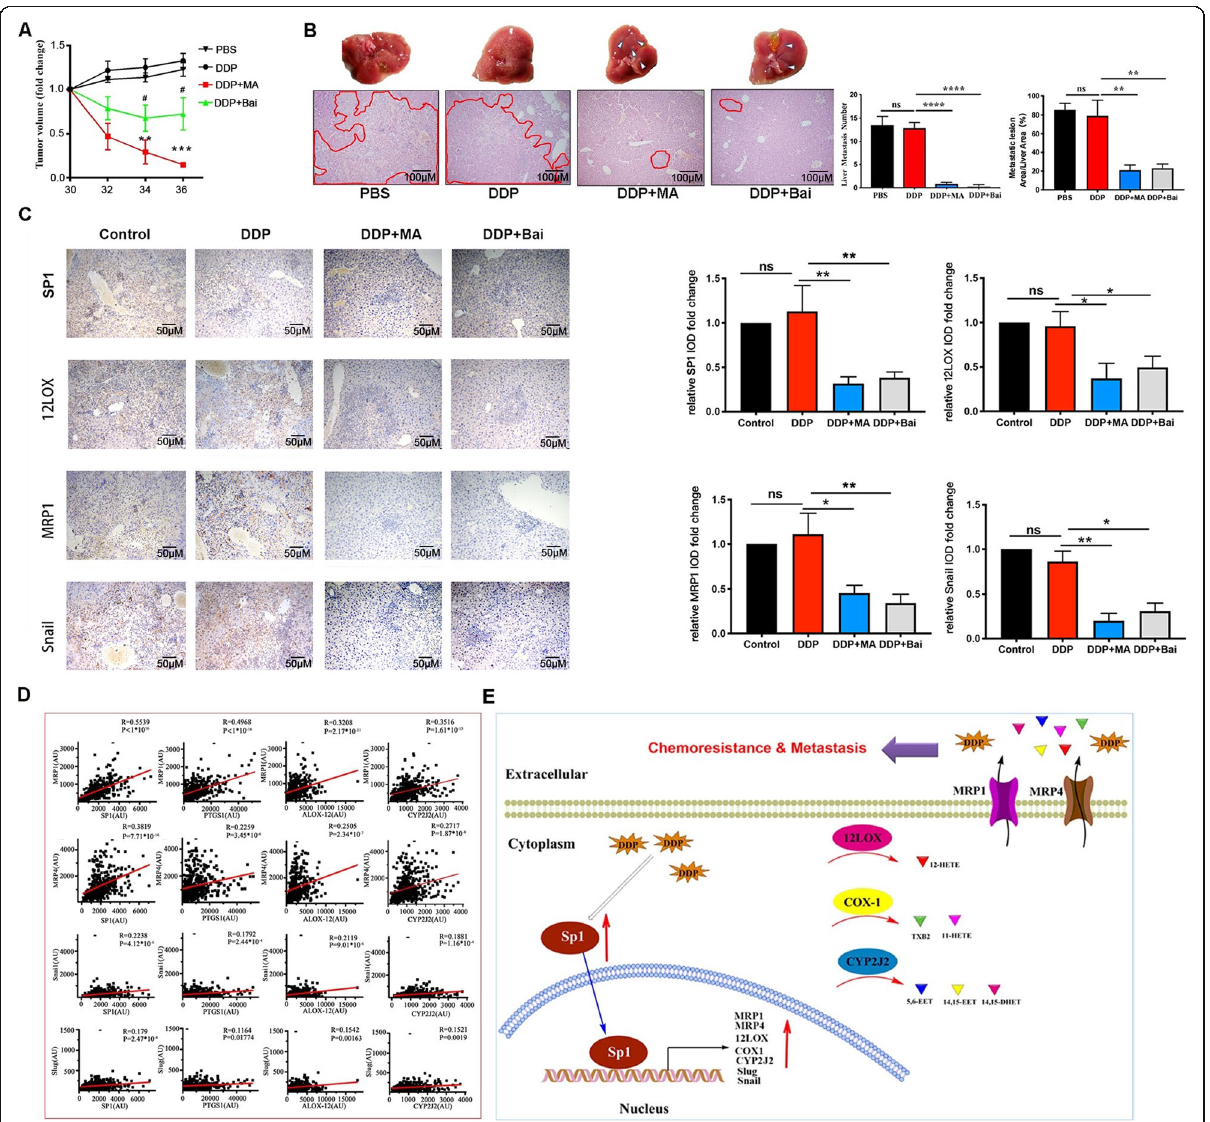
Fig. 4 Blocking SP1 or 12LOX attenuates SKOV3-R tumor growth and reverses metastasis in vivo. a SKOV3-R cells (1 × 10 6 ) were subcutaneously injected in nude mice, tumor reached ~ 300 mm 3 at Day 30, then the mice were treated with PBS or DDP (1 mg/kg) or DDP (1 mg/kg) plus Bai (30 mg/kg) or MA (0.5 mg/kg) once every 2 days. The tumor volume was assessed until Day 36. b SKOV3-R cells (1 × 10 6 ) were subcutaneously injected in nude mice. The mice were treated with PBS or DDP (1 mg/kg) plus Bai (30 mg/kg) or MA (0.5 mg/kg) every 2 days in the third week. Mice were sacrificed for assessment of liver metastasis at Day 21. The overall view of the livers, H&E staining and the metastasis numbers in live lesions (right panel) were determined. Data in ( b ) are expressed as mean ± SEM for 5 mice. c IHC of SP1, 12LOX, MRP1 and Snail in liver tissues in four groups including control (PBS), DDP, DDP plus MA, DDP plus Bai. IOD against control group in above groups were depicted in fold change. d The correlation between SP1, 12LOX, COX1, CYP2J2 with MRPs, Slug and Snail. Pearson correlation coefficient was used to analyze the correlation between MRPs and EMT markers with SP1 , 12LOX , COX1 , and CYP2J2 using the clinical database GSE13876. e Schematic diagram of SP1-driven chemoresistance and metastasis. Data are expressed as mean ± SEM for 5 mice. * P < 0.5, ** P < 0.01, *** P < 0.001, **** P < 0.0001; DDP+ MA vs. DDP; # P < 0.05, DDP + Bai vs.